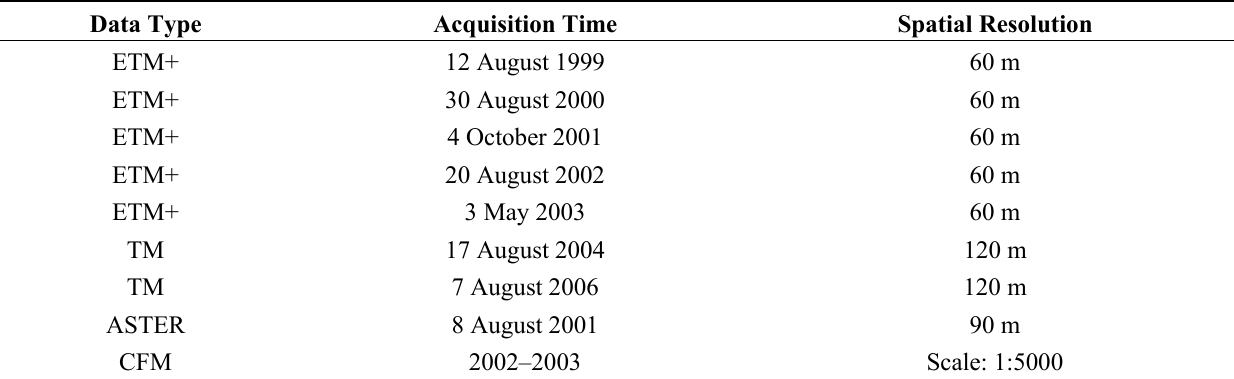
Table 1. Dataset used in this research. CFM: Coal Fire